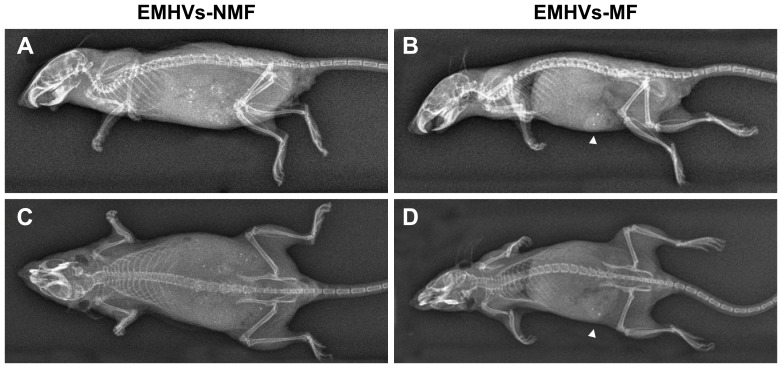
Localized targeted in vivo distribution of EMHVs after systemic tail vein administration in mice.Representative X-ray images of mice injected with EMHVs and treated with null (A and C) or 1,000 KOersted external static magnetic field (B and D) applied for 30 min in correspondence of the abdomen, are depicted. After 1 hour from the injection, a rather sparse distribution of nanoparticles (white irregular shadow/dots) was found inside metabolic organs and tissues exposed to null magnetic field (EMHVs-NMF, A sagittal and C frontal planes, respectively). After exposure to the magnetic field (EMHVs-MF, B sagittal and D frontal planes, respectively), nanoparticles concentrated in the target tissue (abdomen) resulting in a sharp intense signal (arrow).